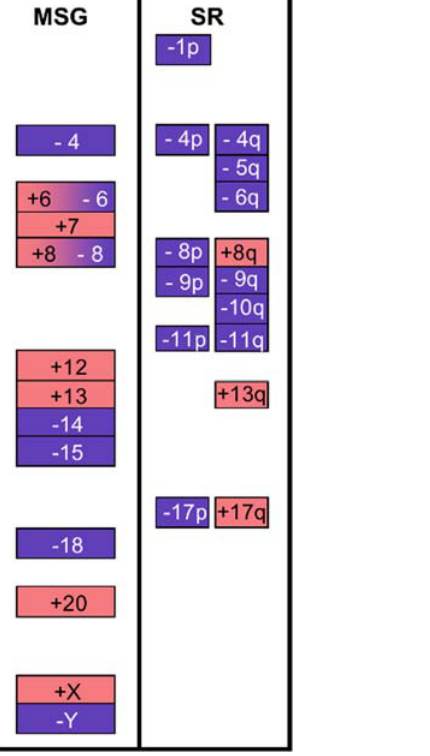
Figure 2. Most relevant chromosomal targets for missegrega- tion (MSG) and structural rearrangements (SR) are mutually exclusive. Among the chromosomes or chromosome arms that are likely to be selected for during tumor progression according the likelihood modeling (see Figures 1B and 1D), only those for which a significative tendency towards either gain or loss were retained (Chi2 test, under the null hypothesis, the numbers of gains and losses should be distributed uniformly). Chromosomal losses (blue background) and gains (red background) are distinguished.